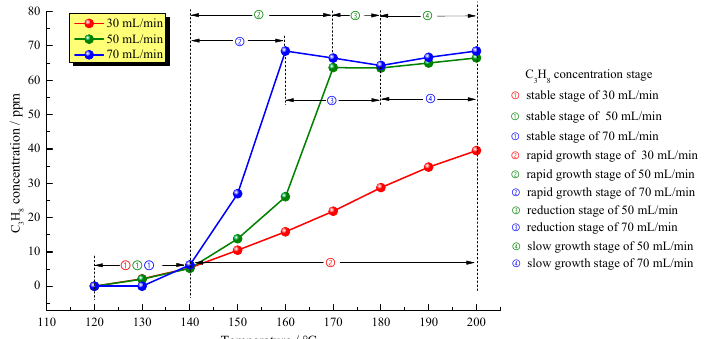
Figure 6. Relationship between the C 3 H 8 concentration and the temperature at different air supply rates.